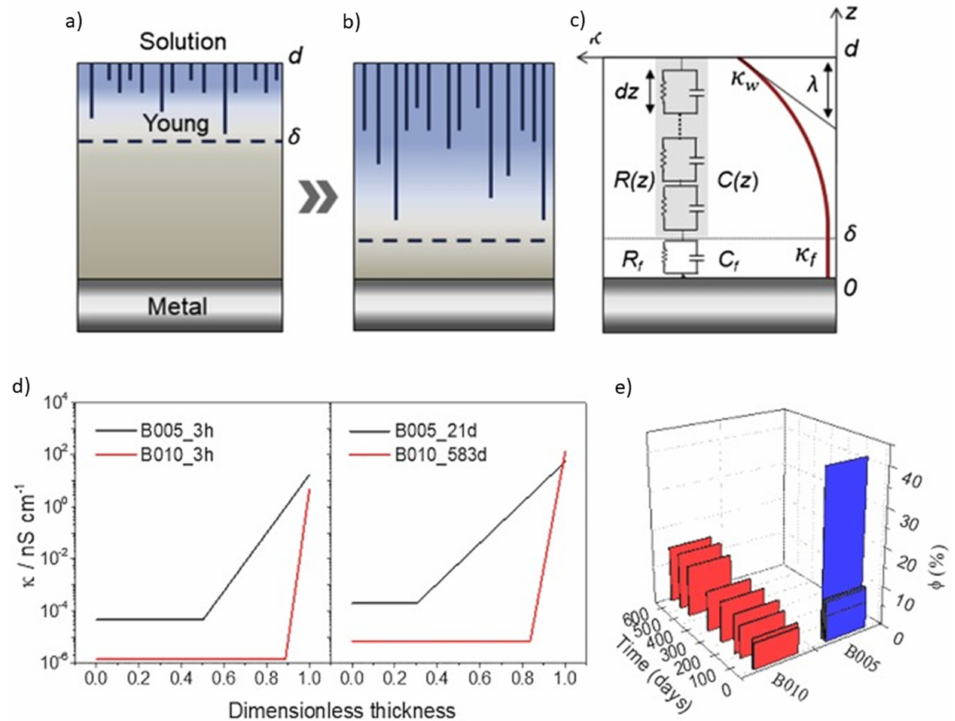
Figure 15. Representation of electrolyte permeation through a coating according to the two-layer model: ( a ) the initial stage of contact with the solution; ( b ) after long-term exposure; ( c ) the corre- sponding continuous time-constant distribution, resulting from an exponential conductivity profile along the z-axis in the water uptake zone; ( d ) profiles of conductivity vs. dimensionless thickness for different immersion times in 3.5% NaCl for B005 (3 h and 21 days) and B0.1 (3 h and 583 days) coatings; ( e ) time dependence of water uptake. Reproduced with permission of Elsevier